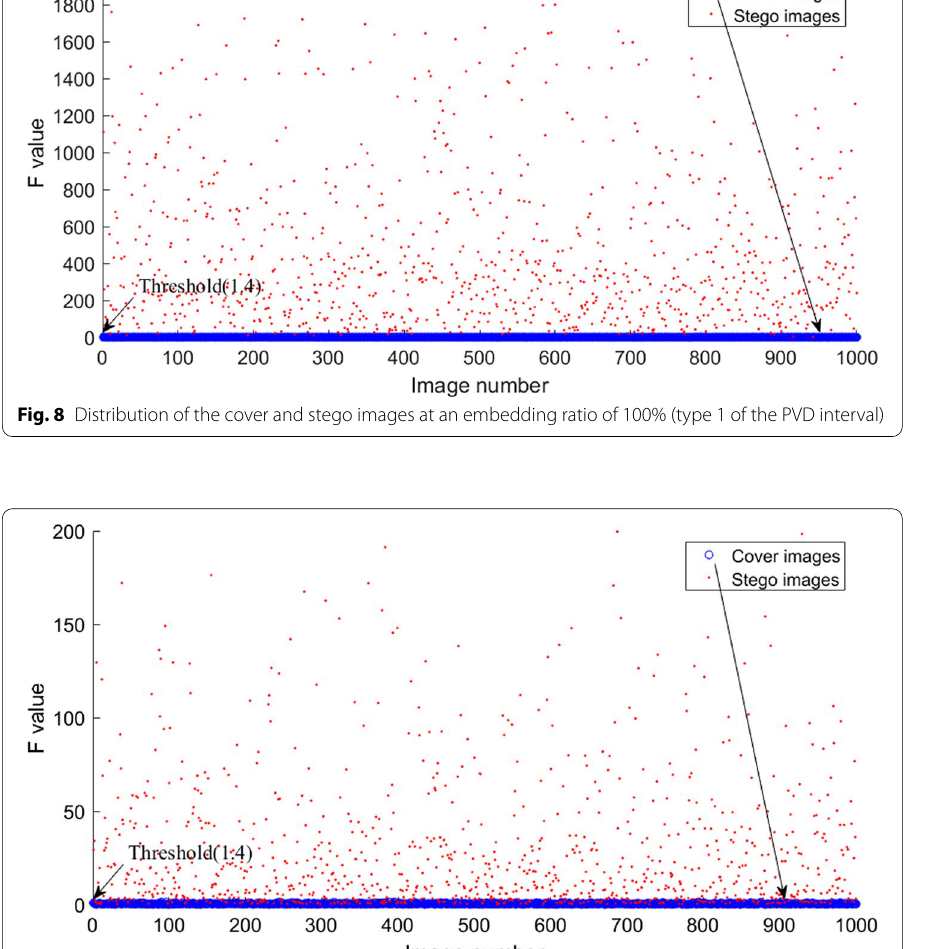
Table 3 Results of the proposed technique (type 1 of the PVD interval) Embedding True positive False ratio (%)